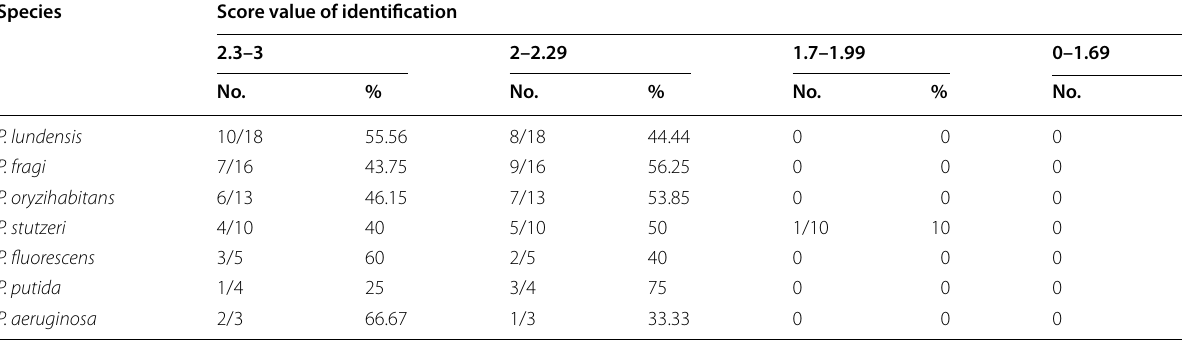
Table 4 Score values for 69 Pseudomonas spp. detected in chicken meat by PMFT